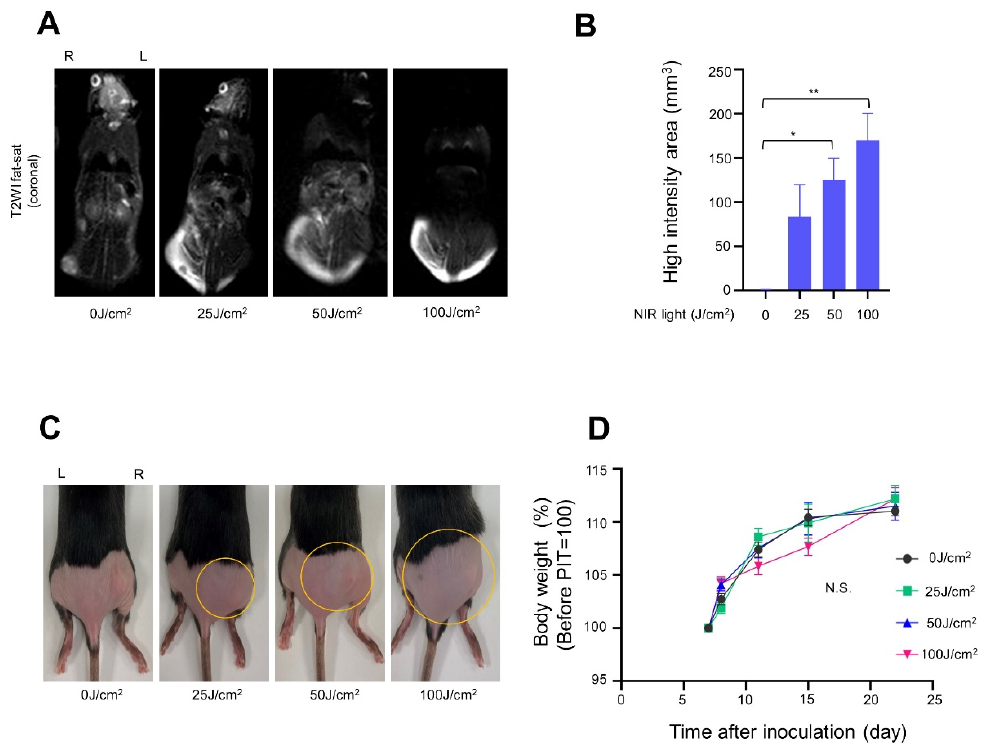
Figure 7. Side effect of NIR-PIT with Cet-IR700 in mEERL-hEGFR tumors: ( A ) edema was assessed by T2WI fat-sat MRI in the NIR-PIT-treated mice at 24 h; ( B ) the range of high signals was quantified using Image J ( n = 3; one-way ANOVA followed by Tukey’s test; *, p < 0.05 and **, p < 0.01); ( C ) the appearance 24 h after light exposure, where the yellow circles indicate the edema-affected area; ( D ) the percentage of change from immediately before irradiation ( n = 10; two-way ANOVA; N.S.: not